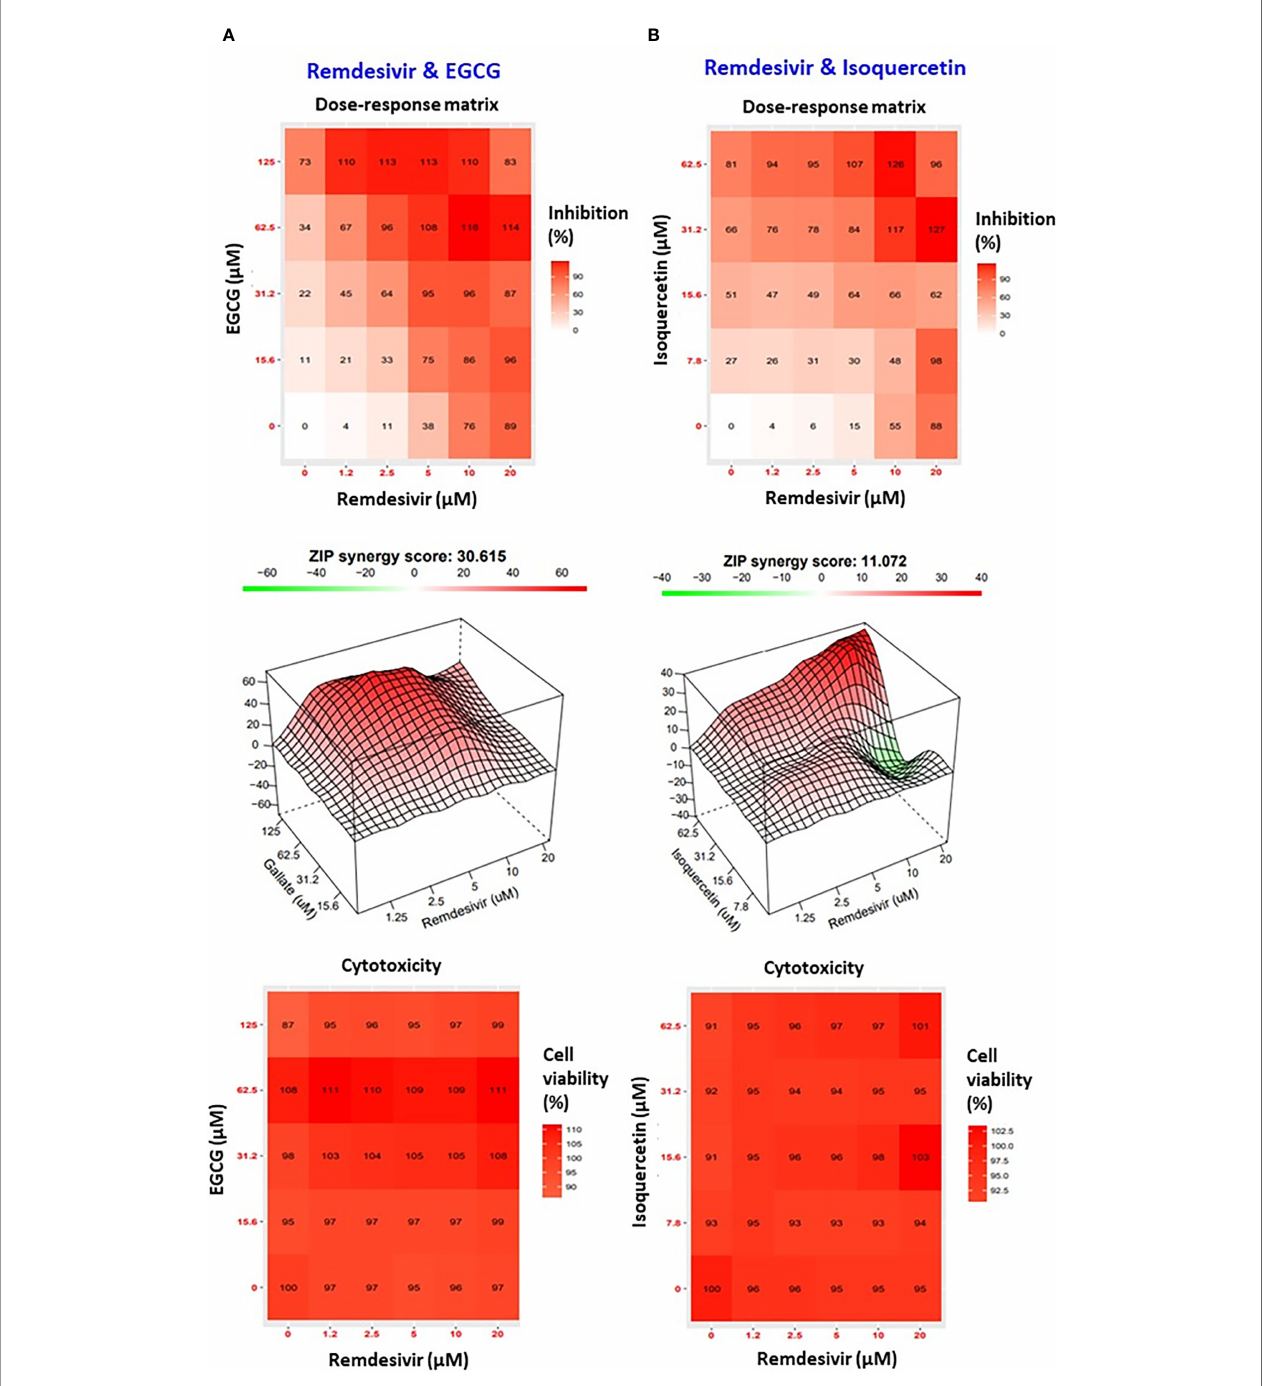
FIGURE 2 | Synergistic antiviral effects of polyphenols and Remdesivir against SARS-CoV-2. (A) Combination of Remdesivir- EGCG. At the top, dose-response matrix with the percentage of inhibition induced by single and combination drugs on SARS-CoV-2 infected cells (red box=high percentage of virus inhibition); In the middle, interaction surface response between these compounds with the synergy score for the combination using ZIP reference model (red areas correspond to a synergy score larger than 10 = synergistic interaction between two drugs); At the bottom, cytotoxicity evaluation on uninfected cells (red box=high percentage of cell viability) of (A) Remdesivir-EGCG and (B)